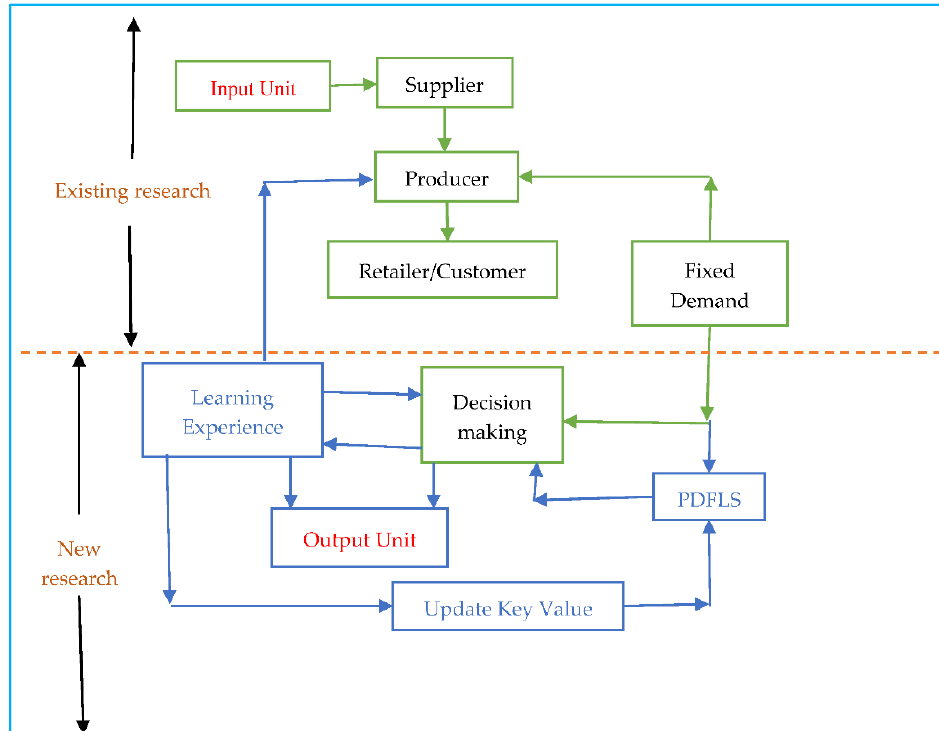
Figure 7. Schematic overview of the proposed model.